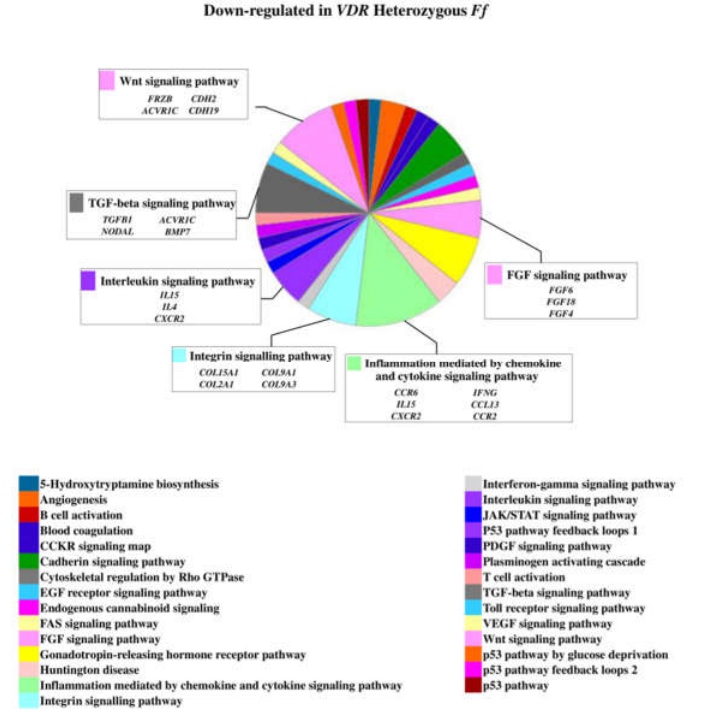
Figure 2. Downregulated genes and related pathways in heterozygous Ff disc cells. Pie chart obtained by Panther.